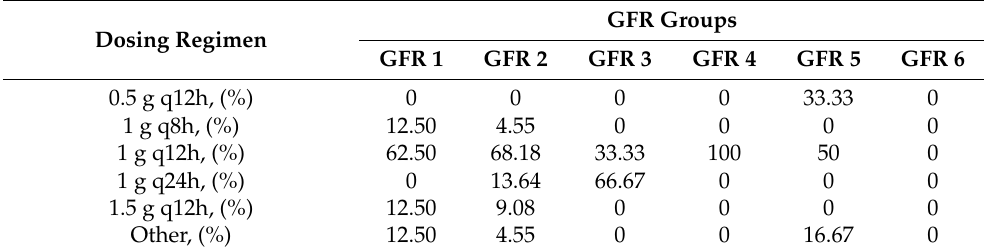
Table 4. Dosing regimen of vancomycin until the first TDM based on GFR in the hospital with a TDM